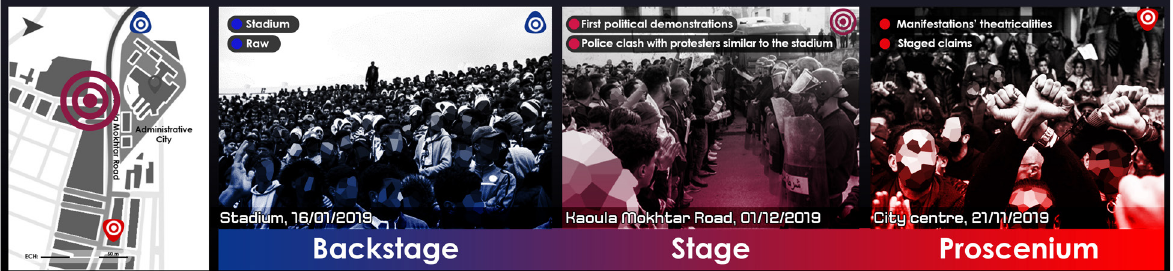
Fig. 3. From left to right; situation of urban theatericalities (Source: own study.), scenic shift from the stadium (Chemcham 2019a) to the street (Chemcham 2019d) and its theatricalisation (Chemcham 2019c).